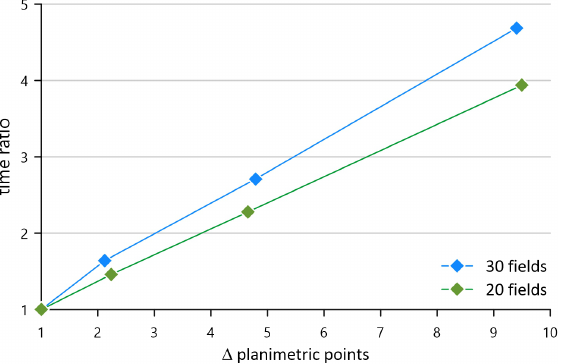
Figure 12. Time increment for measurement to planimetric grid density and number of calculation